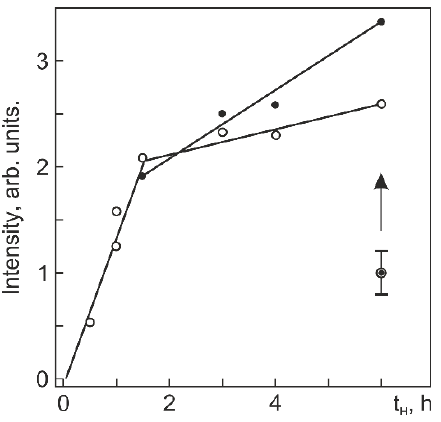
Figure 7. Peak intensity at 2Q ≈ 22° (ο) and 2Q ≈ 45° (● ) vs. hydrogenation time. Such peak intensities correlate with hydrogen distributions in a surface zone ~5.6 µ m thick: after hydrogenation for more than 2 h, hydrogen starts actively diffusing from this zone deep into the alloy but its concentration through a thickness of 2.9 – 5.6 µm becomes maximal after hydrogenation for 6 h (Figure 4). Thus, the absorption of hydrogen by Ti 49.4 Ni 50.6 (at%) during electrolytic hydrogenation leads to the formation of the hydride